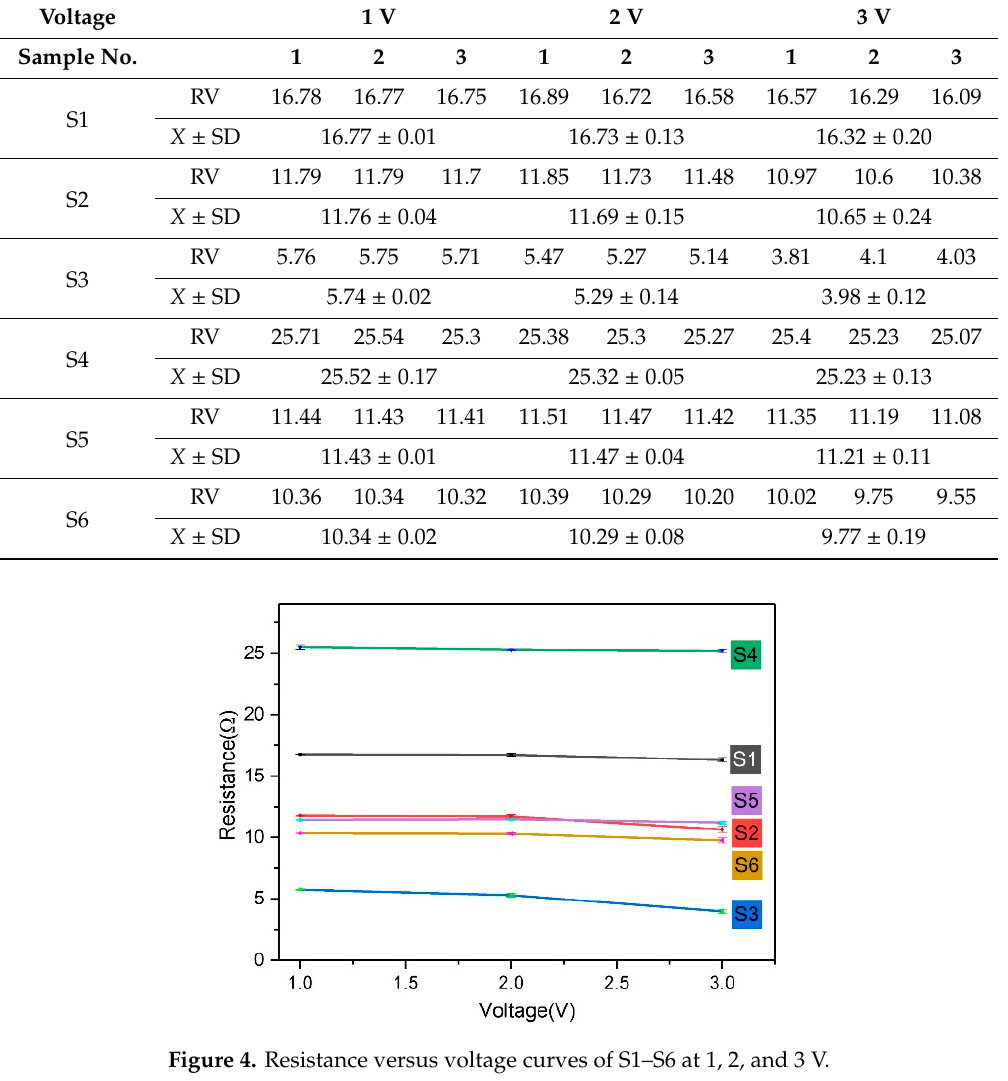
Figure 4. Resistance versus voltage curves of S1–S6 at 1, 2, and 3 V.